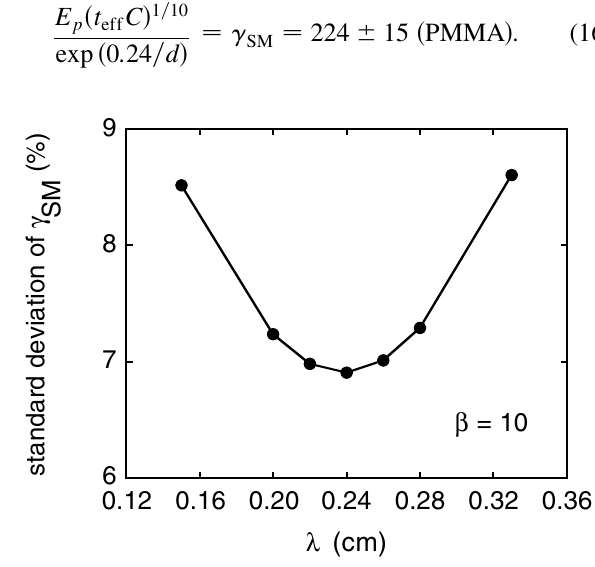
FIG. 4. The fractional standard deviation of the values of (cid:24) as a function of (cid:9) , for the 17 PMMA measurements listed in (cid:12) 10 (cid:11) s and 0 : 5 (cid:12) d (cid:12) 4 : 32 cm . The Table I with 0 : 5 ns (cid:12) t eff plot assumes (cid:2) (cid:9) 10